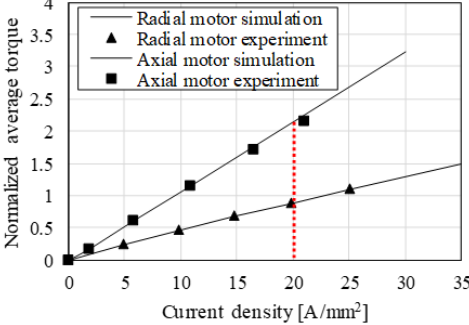
Figure 4. Torque – current density comparison. Figure 4. Torque–current density